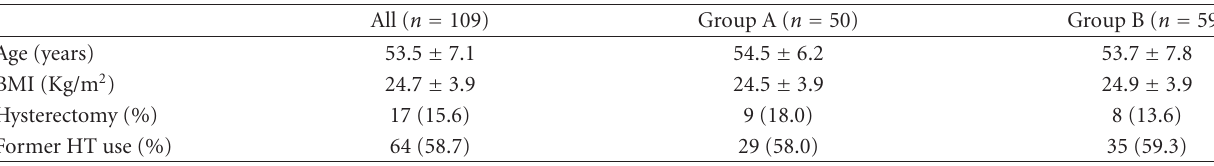
Table 1: Demographic data of studied women at baseline ∗ .